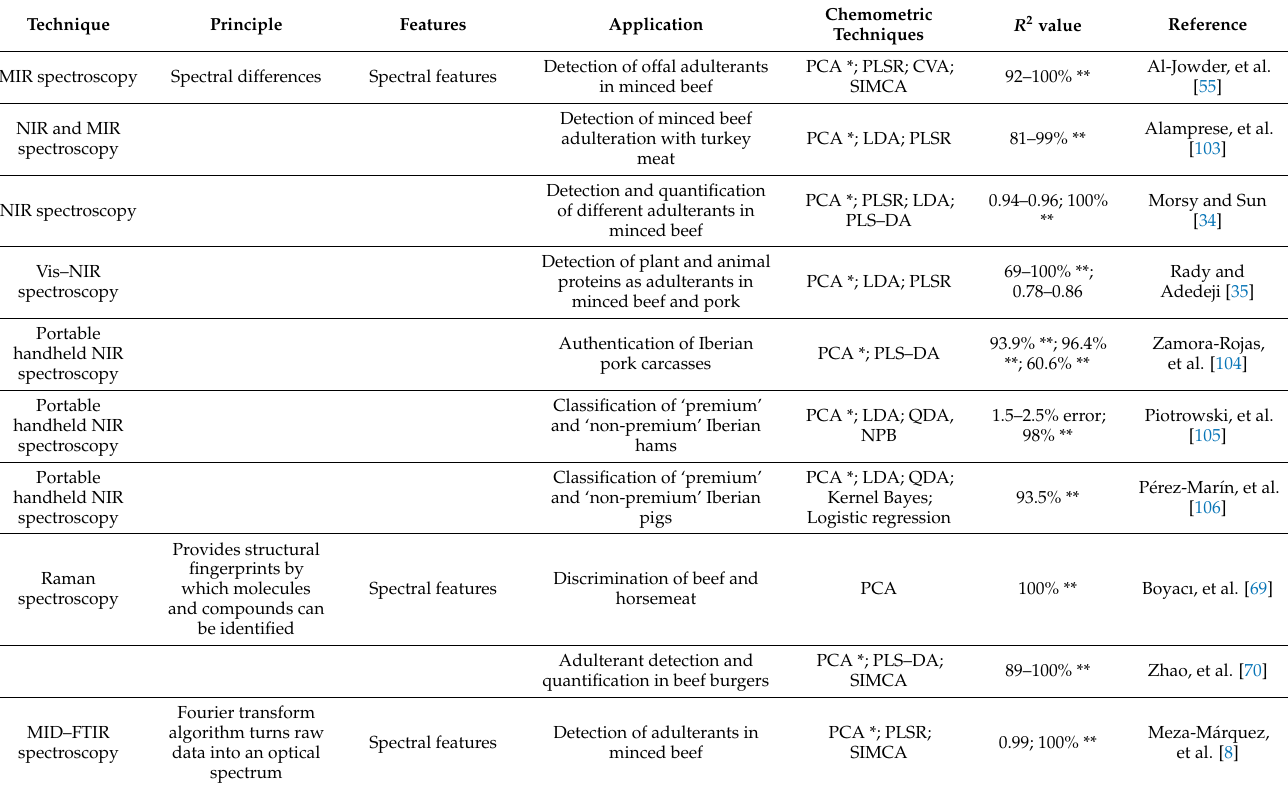
Table 2. A summary of selected non-destructive spectroscopic and imaging techniques and their applications for the authentication and classification of meat